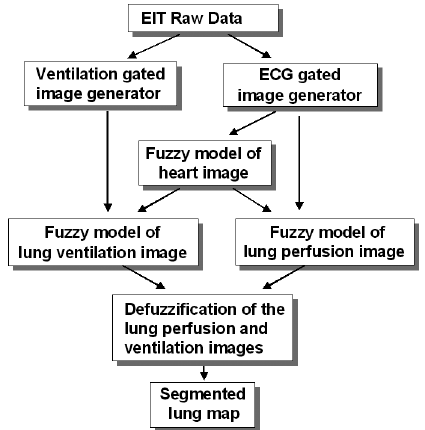
Figure 1 - EIT image analysis